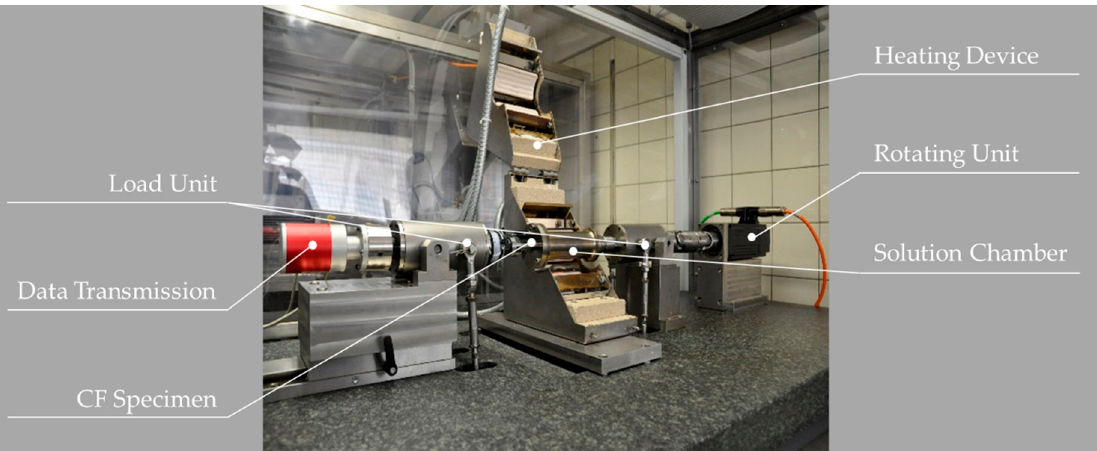
Figure 1. Test setup including a 4-point rotating bending machine with external heating device.